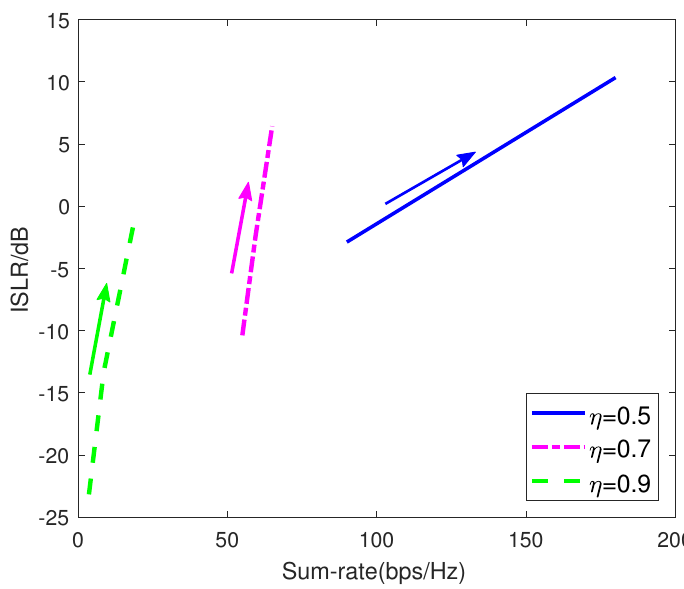
Figure 6. The optimal trade-off